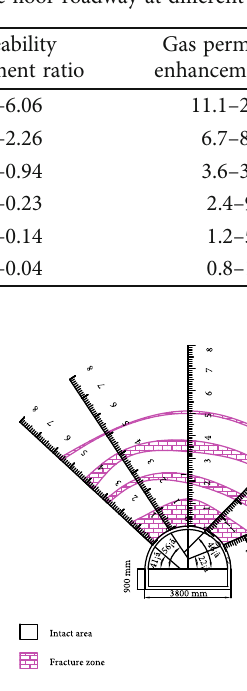
Figure 11: Failure of surrounding rock in 213 fl oor